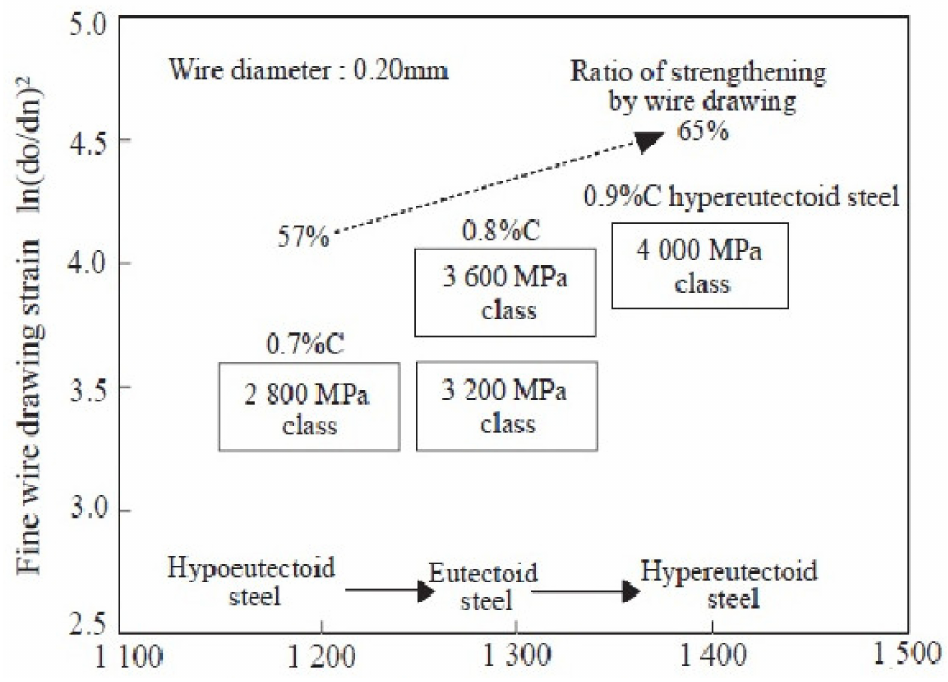
Figure 4. Trend of high tensile strength of steel cord. Reprinted from ref.